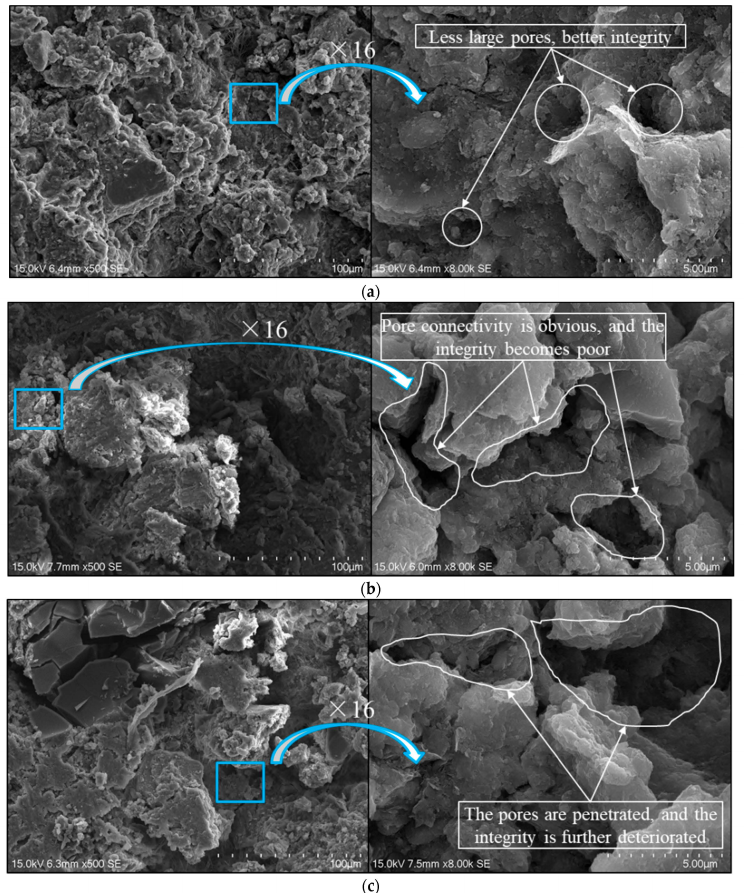
Figure 11. SEM image of cemented soil samples. ( a ) 0% HA content. ( b ) 15% HA content. ( c ) 20% HA